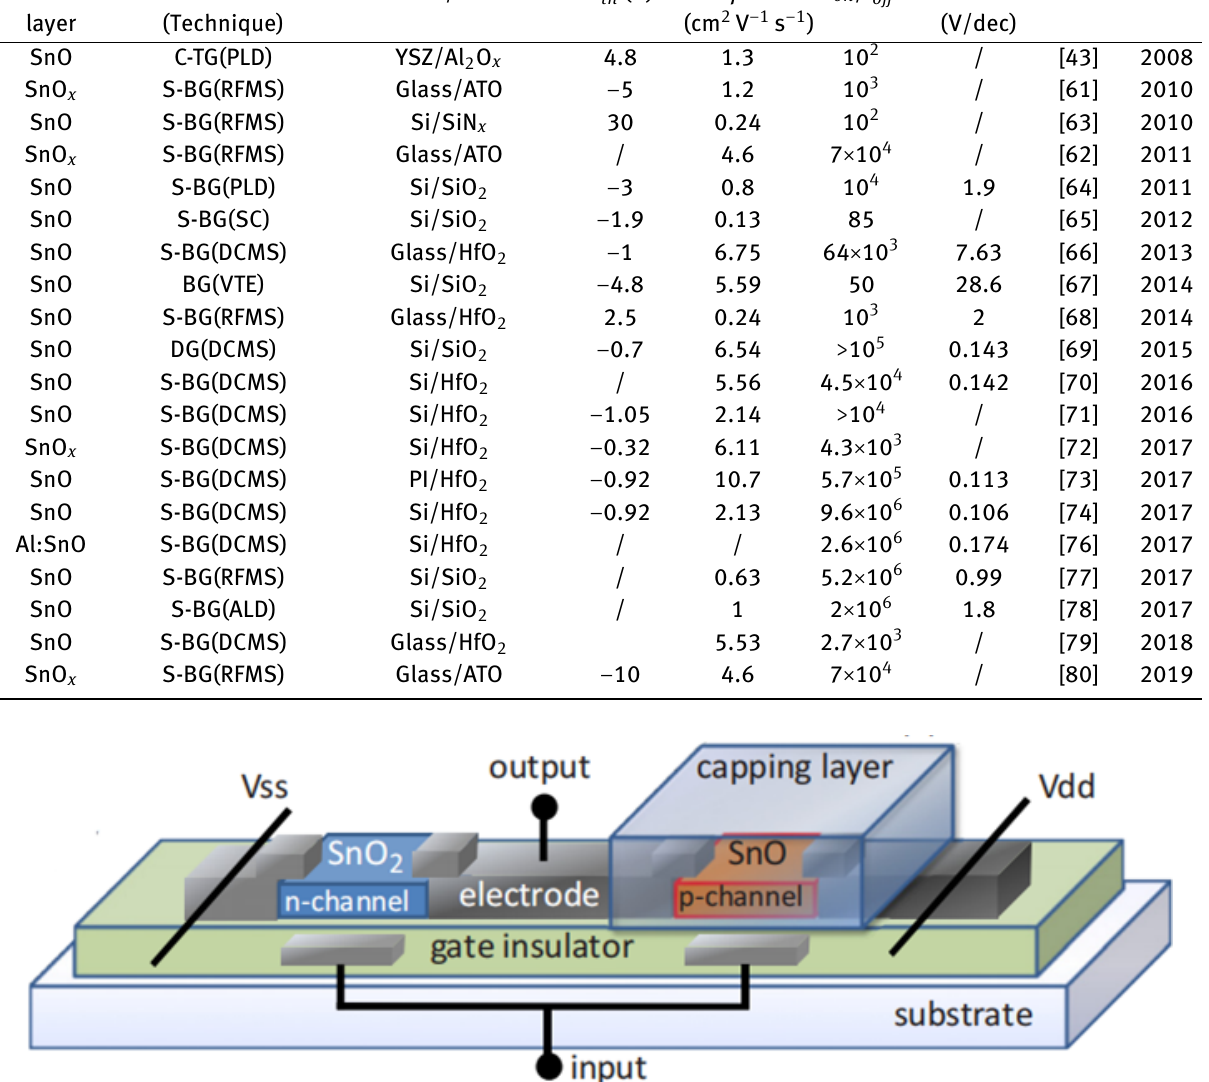
tions of Mott insulators. In 2013, Jiang et al. reported a p- type nanocrystal NiO-based TFT fabricated by simply ther- mally oxidizing (TO) the electron-beam evaporated Ni thin films at 400 ∘ C in air [82], which exhibited a µ of 5.2 FE cm 2 V −1 s −1 , an I /I of 2.2×10 3 and a SS of 3.91 V/decade. on off Figure 14 shows the transfer characteristics of the p-type NiO TFT. By controlling the annealing time, the upper parts of the Ni films were clearly oxidized and the lower parts in contact with the gate dielectric were partially ox- idized to form a quasi-discontinuous Ni layer, which con- tributed to the high mobility of this